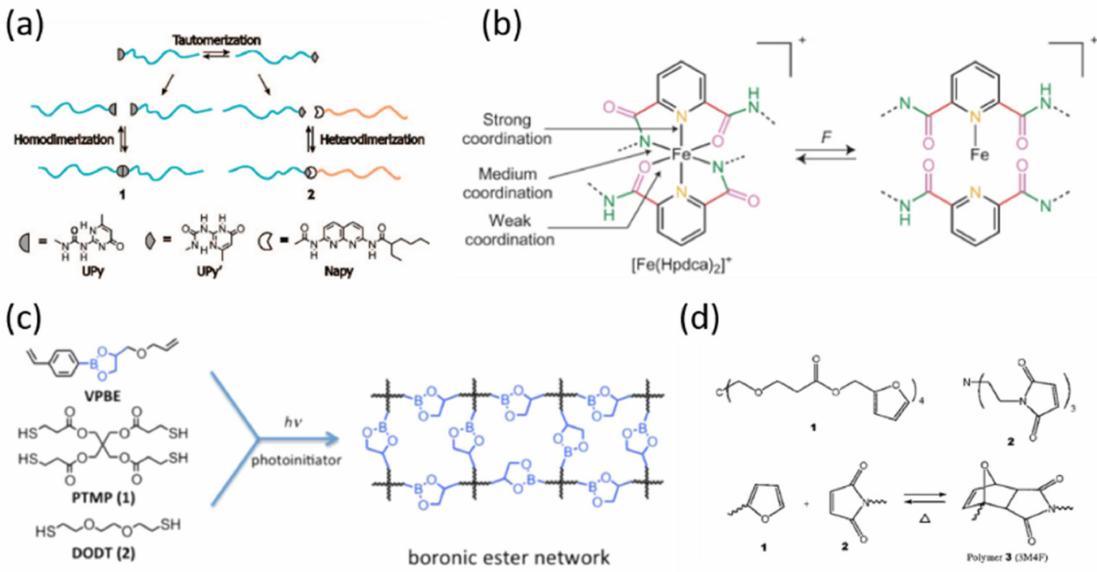
Figure 2. Typical self-healing mechanisms based on chemical approaches. ( a ) UPy groups in end- functional MHB polymers based on hydrogen bonds [26]. Copyright 2008, American Chemical Society; ( b ) the reversible rupture and reconstruction process of [Fe(Hpdca)2]+ based on M–L coordination interactions [32]. Copyright 2016, Springer Nature; ( c ) the synthesis of boronic ester network materials based on dynamic covalent bonds [33]. Copyright 2015, American Chemical Society; ( d ) reversible Diels—Alder reactions based on covalent bonds [34]. Copyright 2002, American Association for the Advancement of